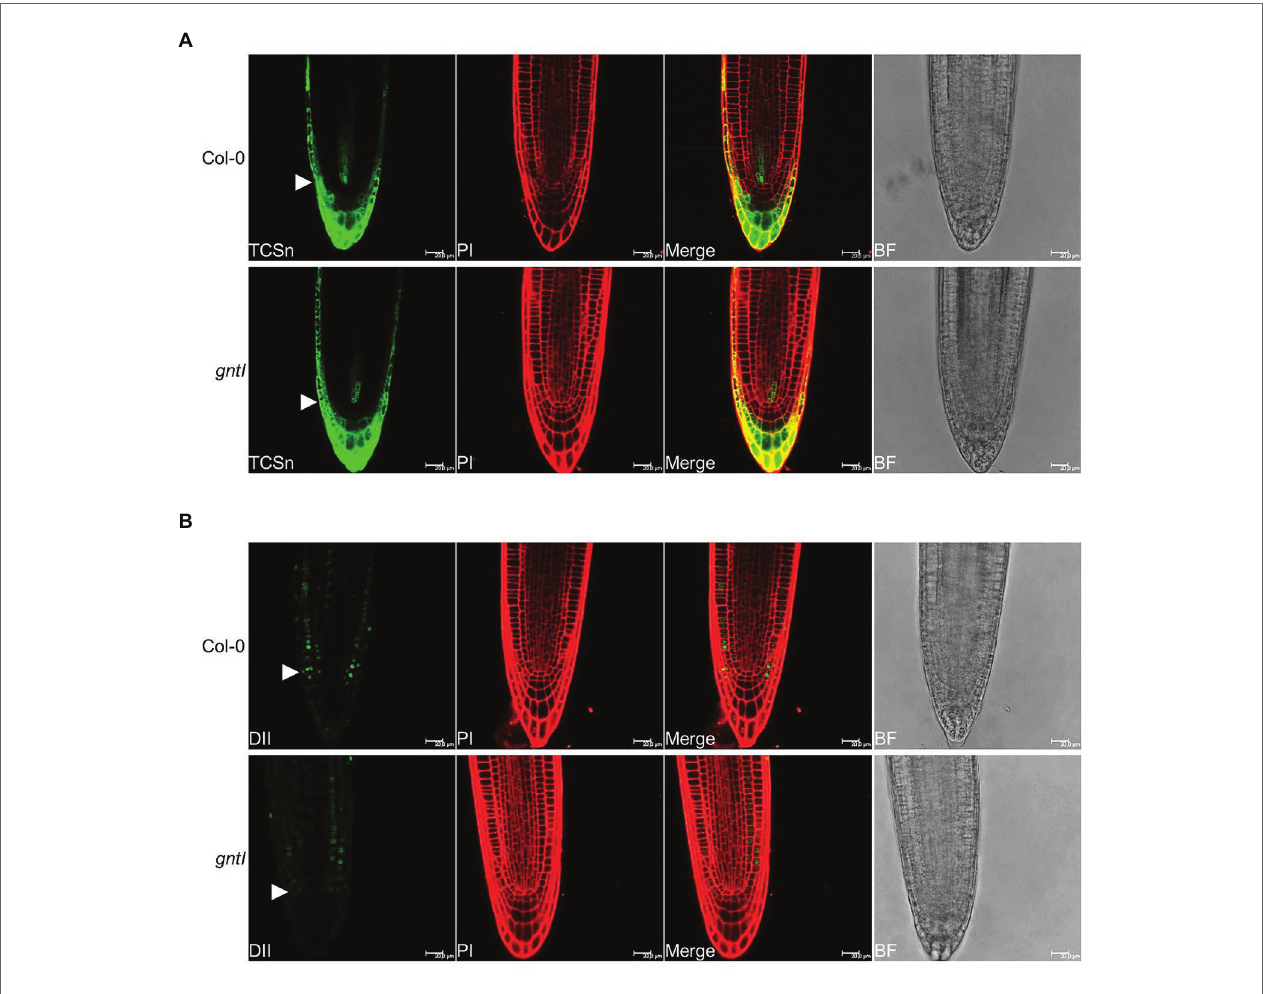
FIGURE 3 | Roots compromised in complex N-glycan modification display a wild type-like CK and an increased auxin signaling output. Pictures of the representative (A) TCSn::GFP (TCSn) and (B) 35S::DII-VENUS (DII) output in Col-0 and gntI root tips are depicted. White arrows point to the level of the